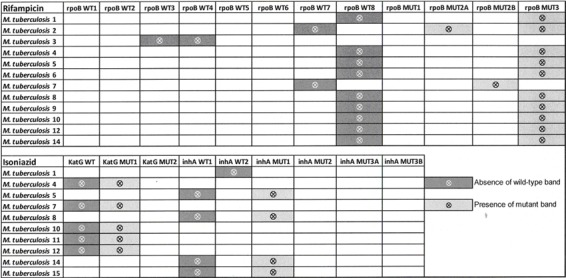
Schematic representation of the Genotype MTBDRplus results
in isolates resistant to rifampicin and/or isoniazid.